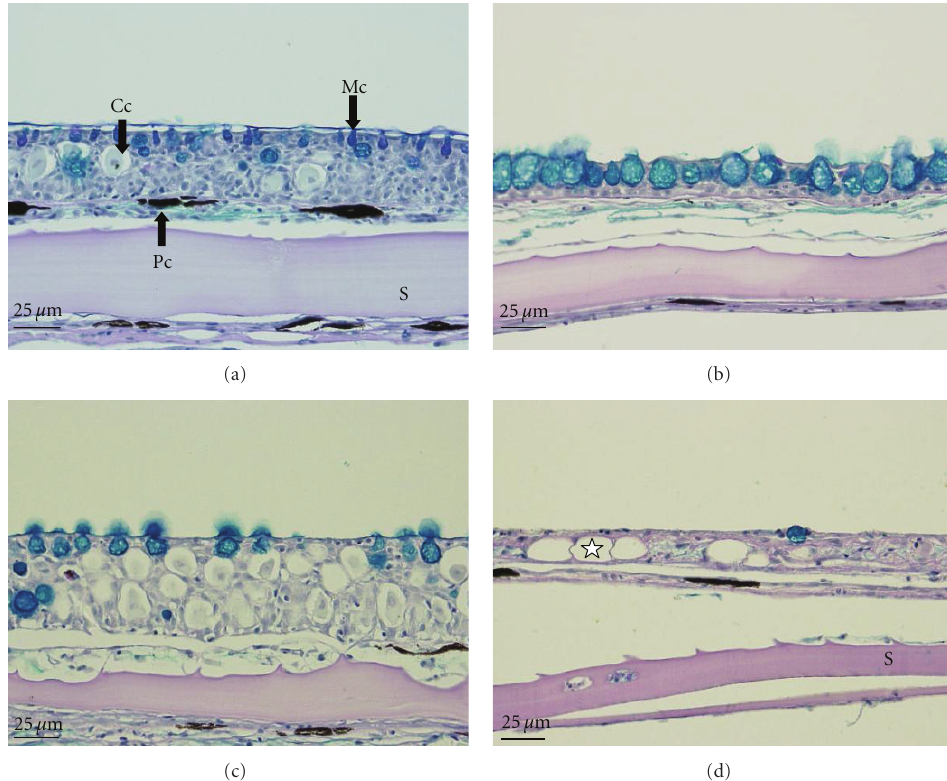
Figure 5: Histological changes in the skin of the common carp ( Cyprinus carpio ) exposed to Ag-NPs for 96h. (a) Control. (b) 50 µ g/L. Increase in mucous cells shown by staining with Alcian blue. (c) 100 µ g/L. Increase in club cells. (d) 200 µ g/L. Vacuolation of the epithelium ( (cid:2) ). Cc: club cell, Mc: mucous cell, Pc: pigment cell, S: scale. AB-PAS (pH 2.5)